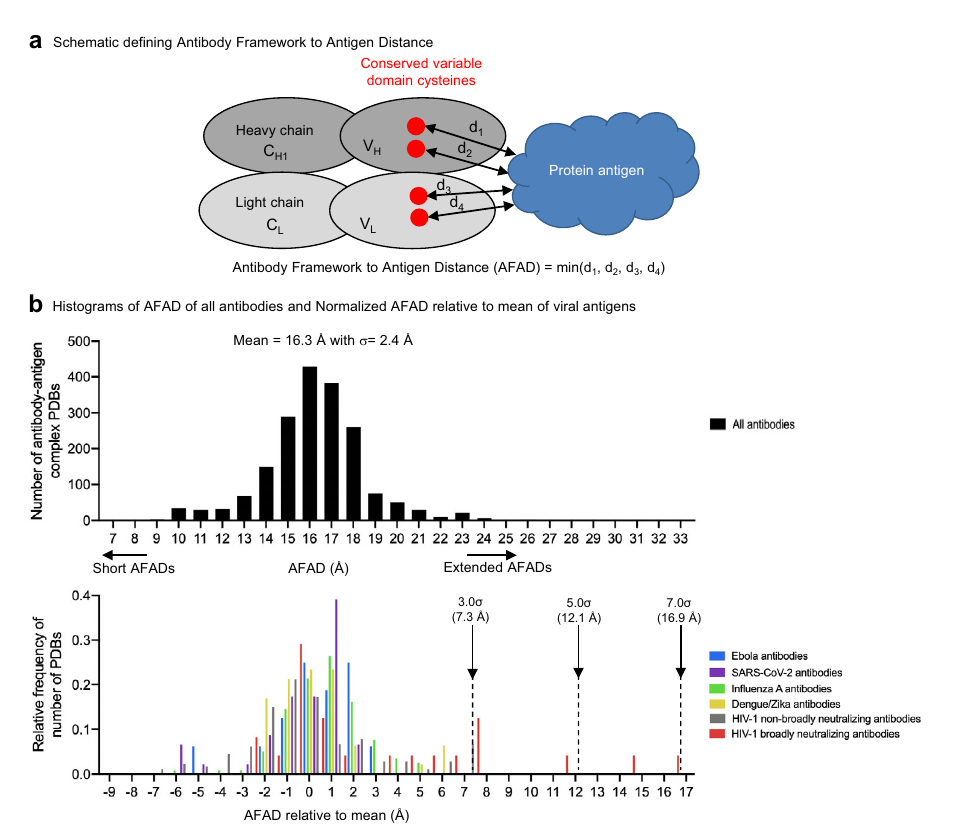
Fig. 1 Analysis of Antibody-Framework-to-Antigen Distance (AFAD) for all antibody complexes in the PDB reveals outliers with extended recognition distances to be exclusively HIV-1 broadly neutralizing antibodies. a Schematic of AFAD calculated from the shortest protein antigen atom-distance to each of the four conserved variable domain cysteines (red). Only protein atoms were used for calculations, excluding distances for cofactors, glycans, and other non-protein atoms. b Histogram of AFAD for n = 1879 antibody complexes in the PDB (black). Normalized AFADs relative to mean are also shown for Ebola virus (blue), SARS-CoV-2 (purple), in fl uenza A virus (green), Dengue/Zika virus (yellow), human immunode fi ciency virus-1 (HIV-1) non-broadly neutralizing antibodies (gray), and broadly neutralizing antibodies targeting HIV-1 (red). AFAD relative to mean for n = 1879 PDB complexes formed a normal distribution as mean values 16.3 + / − 2.4 Å SD. Select HIV-1 broad neutralizing antibody-recognition distances can be extended by more than 3 σ longer. AFADs in the bottom plot are normalized relative to mean (16.3 Å). See also Supplementary Table